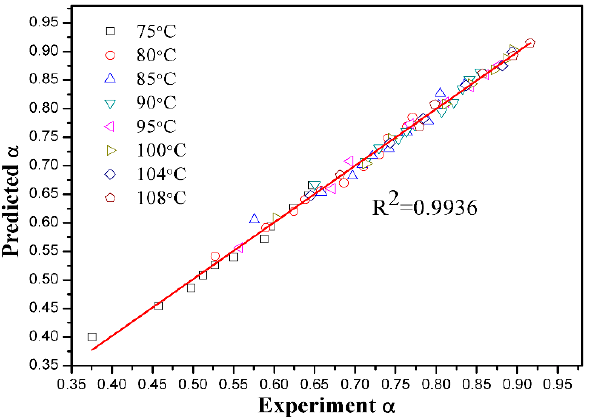
Figure 10. Predicted α against experimental α .